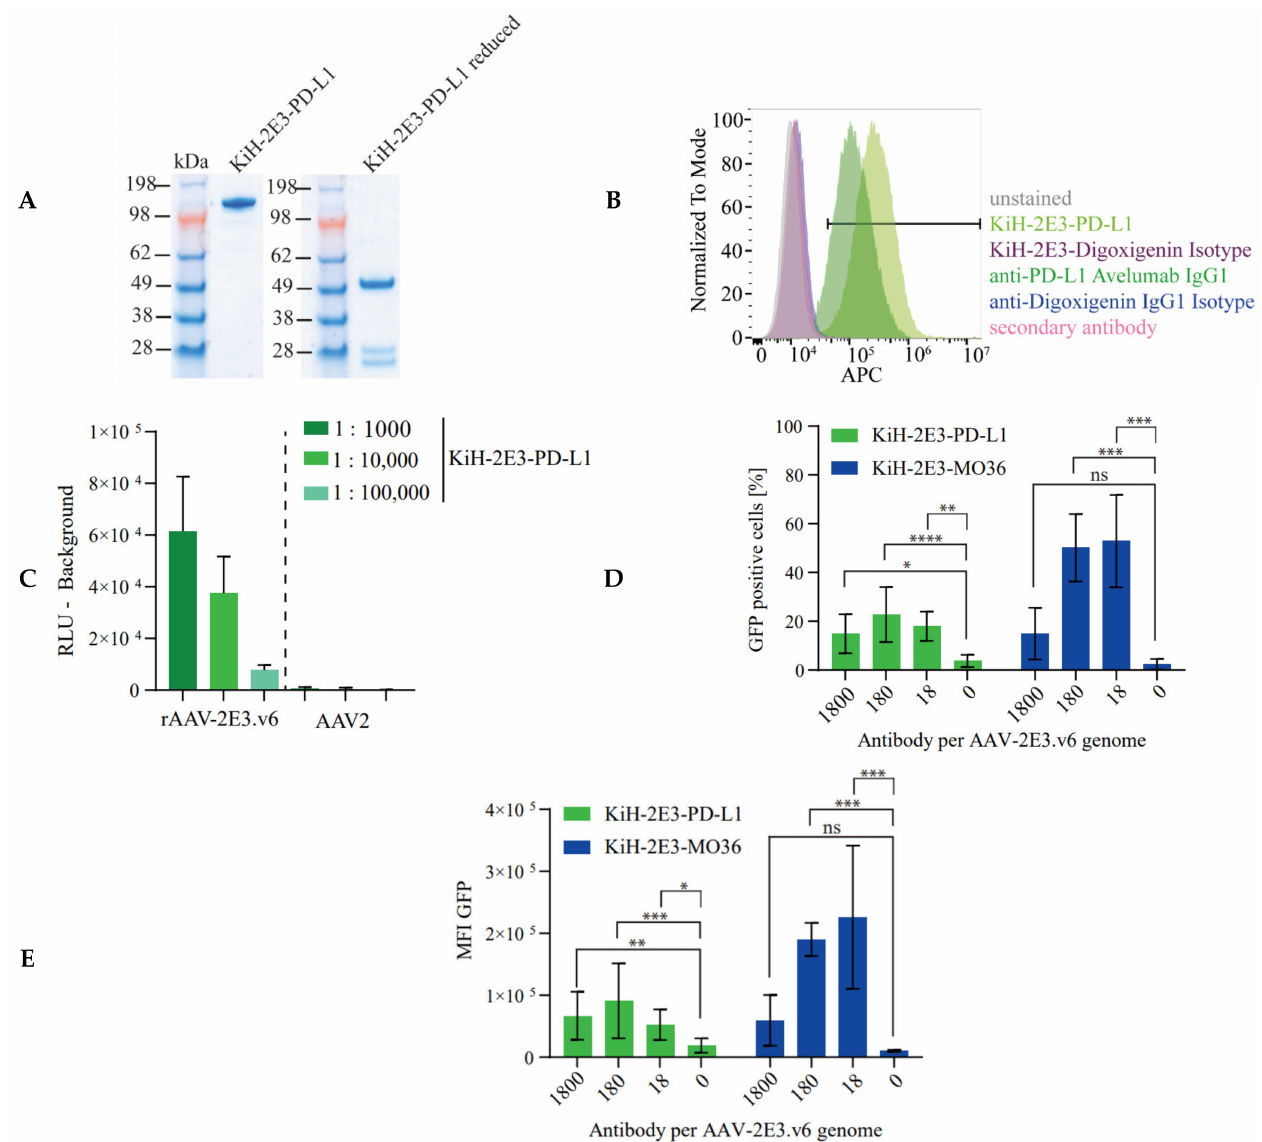
Figure 7. Bispecific antibody modification enabled modular targeting of PD-L1 expressing cells with rAAV-2E3.v6. ( A ) A new bispecific antibody KiH-2E3-PD-L1 was produced and purified. The size difference of kappa and the shorter lambda light chains were visible under reducing conditions. ( B ) Flow cytometry staining of HT1080 cells proved expression of PD-L1 using avelumab, KiH-2E3-PD-L1, and isotype controls. ( C ) KiH-2E3-PD-L1 antibody binding of immobilized rAAV-2E3.v6 and AAV2 capsids. Data show mean + SD of two independent experiments. ( D ) Flow cytometry analysis of GFP expressing HT1080 huFAP cells after re-targeting of rAAV-2E3.v6 by KiH-2E3-PD-L1 in comparison to KiH-2E3-MO36. Plot of GFP positive cell proportoins and ( E ) MFI levels. Data show mean ± SD of three independent experiments; one-way ANOVA, uncorrected Dunn’s test, * p < 0.05; ** p < 0.01; *** p < 0.001, **** p <